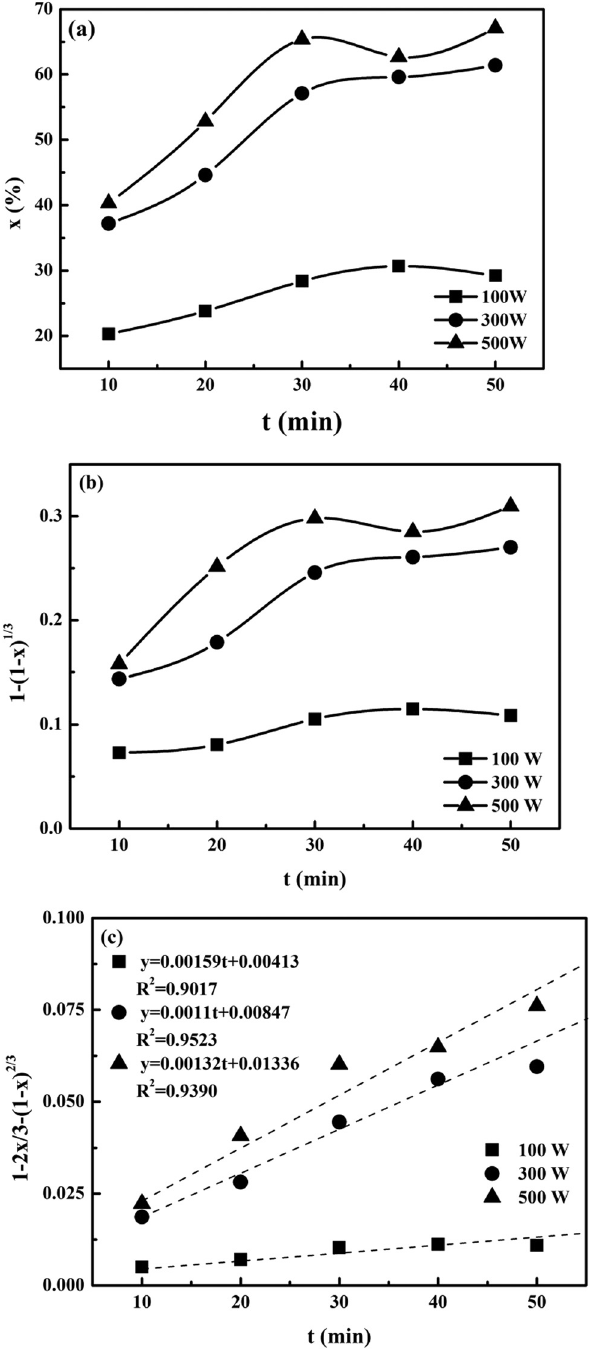
Figure 5: The relationship between ( a ) t and x , ( b ) t and 2 3 with ultrasonic - assisted ( ) / x 1 − 1 − 1 3 ( c ) t and ( ) / x x 1 − − 1 − 2 3 leaching ( acid leaching conditions – H C O 2 2 4 concentration: 10 g/L, HCl concentration: 5%, L/S ratio: 5 and temperature: 60°C )